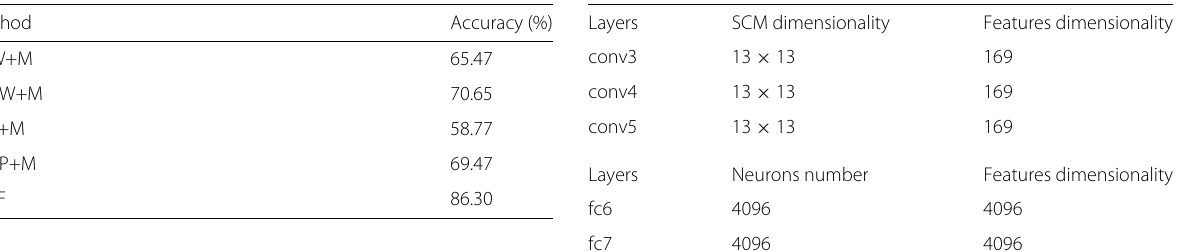
Table 6 The feature dimensionality of different